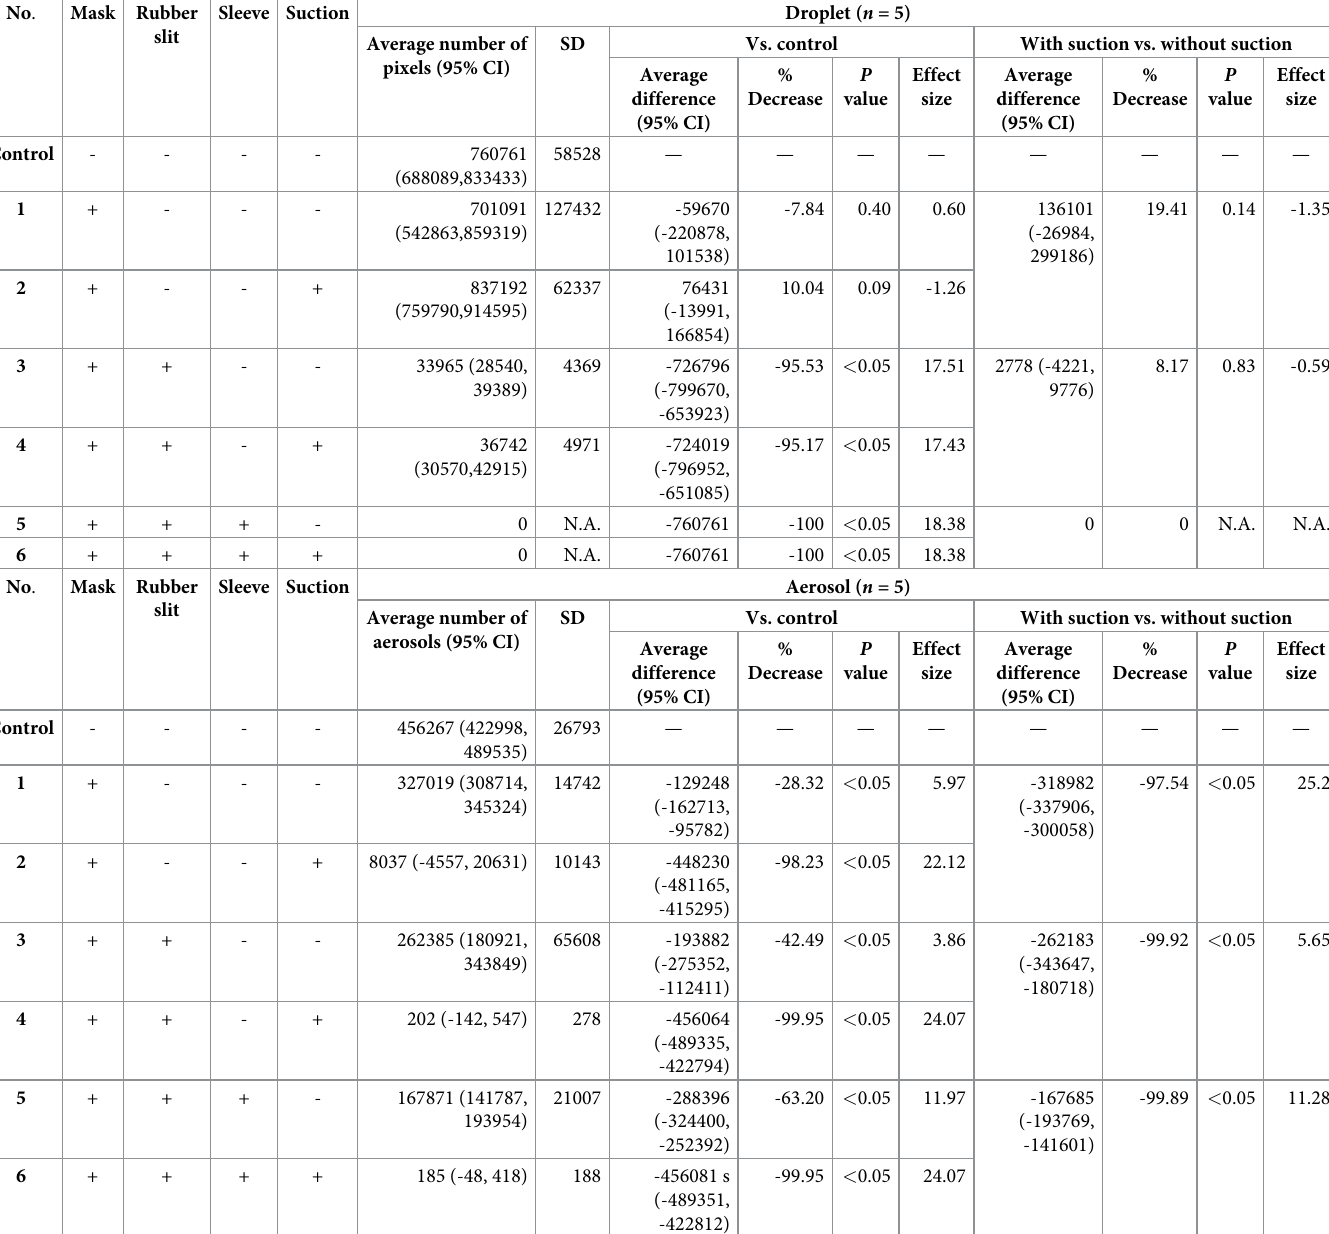
Table 1. Results of the droplet and aerosol